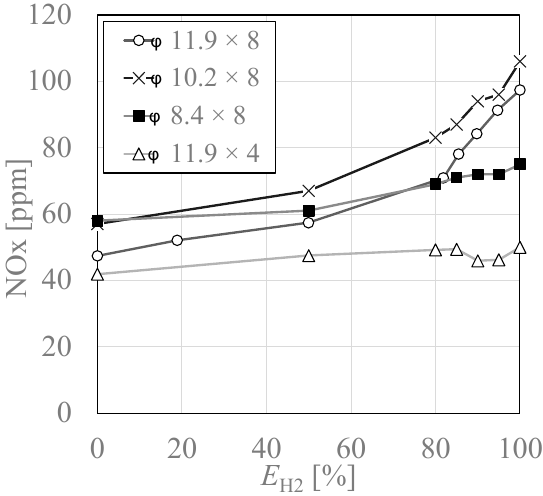
Figure 11. NOx for different E H2 under each air nozzle case, at 1273 K. Input = 174 kW, λ = 1.2, P = +15 Pa.